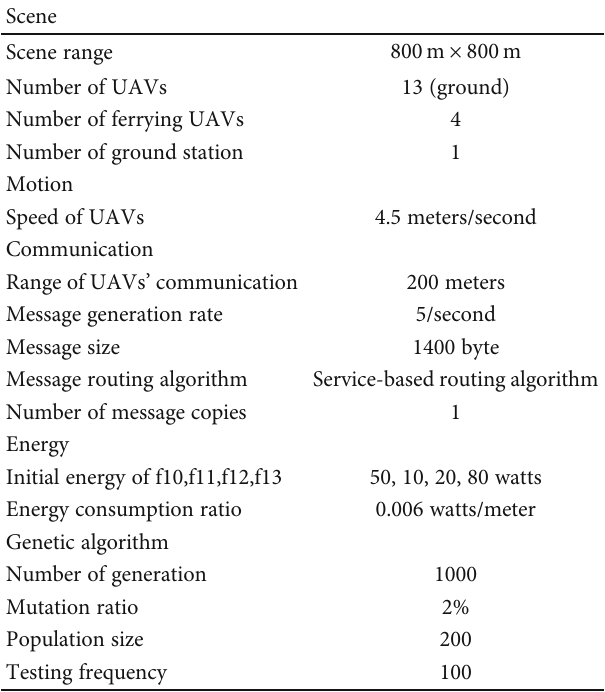
Table 2: Experimental